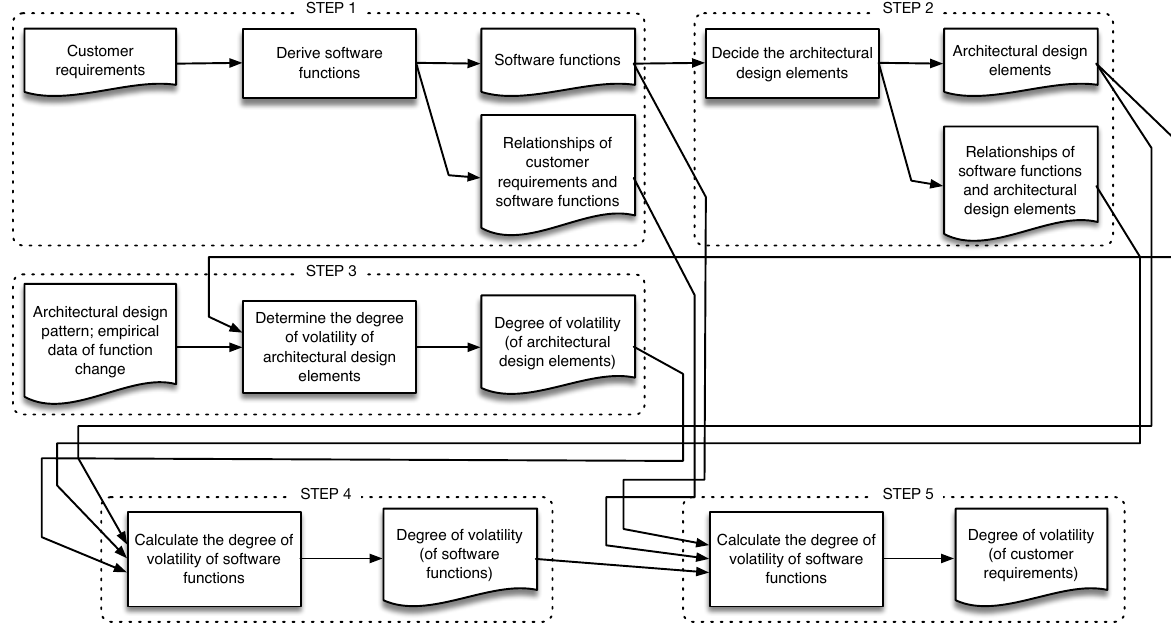
Figure 1. A diagram showing the steps to conduct the customer requirements volatility analysis using